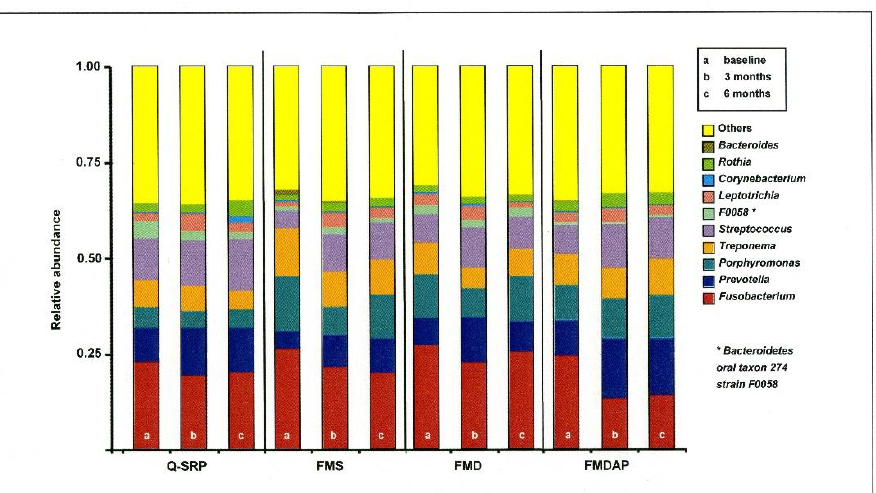
Figure 1. Microbial community composition at genus level (top 10 with the highest relative abun- dance). The top four genera were Fusobacterium , Prevotella , Porphyromonas , and Treponema . No statistically significant differences were identified among these genera within the periodontal treat- ment groups over time. Q-SRP: quadrant-wise subgingival scaling and root planing (SRP); FMS: full-mouth SRP without the use of antiseptics; FMD: full-mouth SRP within 24 h with disinfection using antiseptic applications; FMDAP: FMD combined with the use of subgingival erythritol air-polishing.